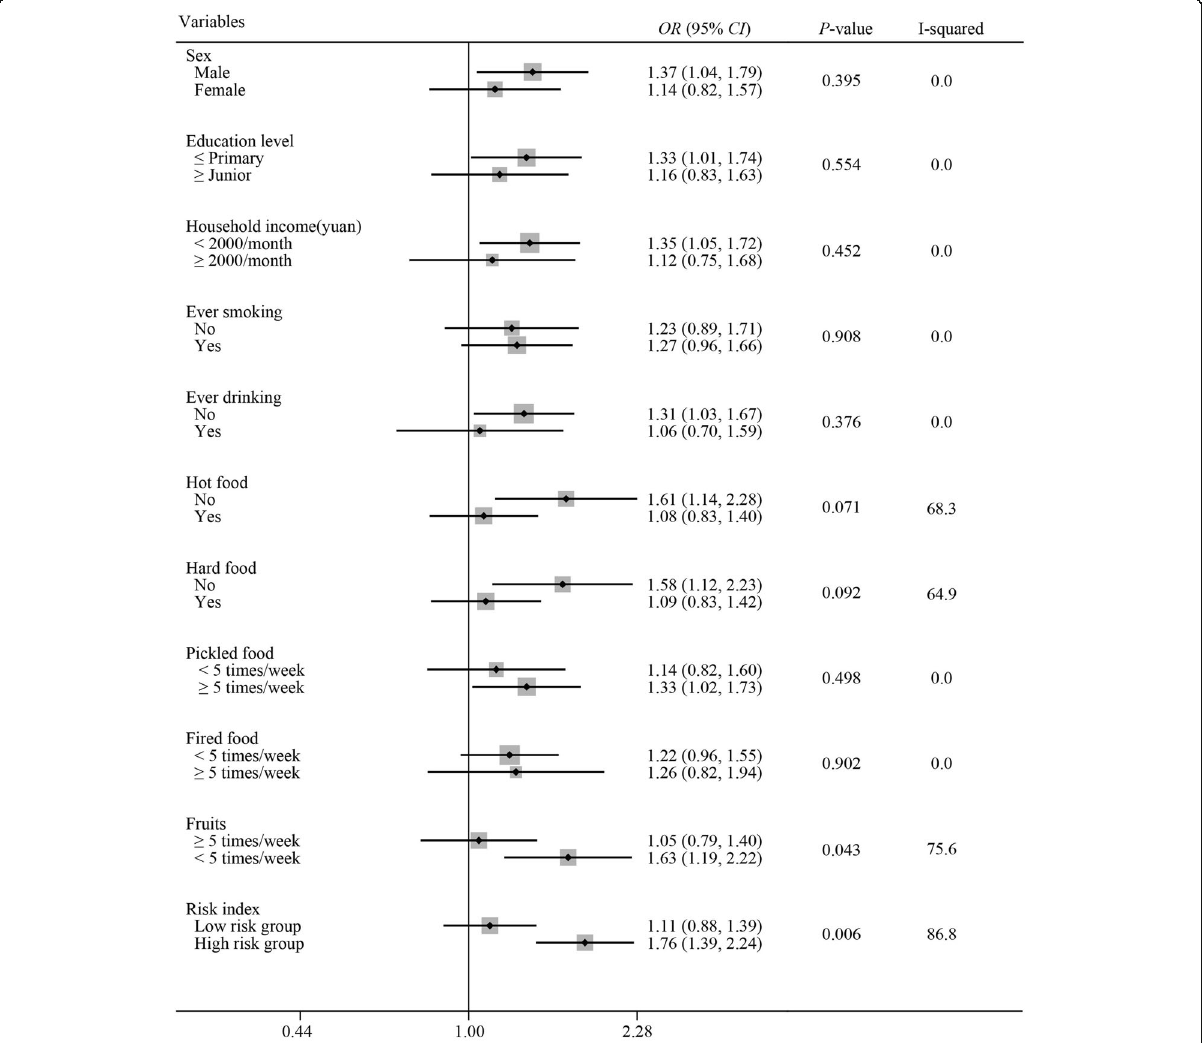
Fig. 1 Multivariable odds ratios (odds) and 95% CI for the association between the oolong tea drinking temperature and ESCC risk across strata of various